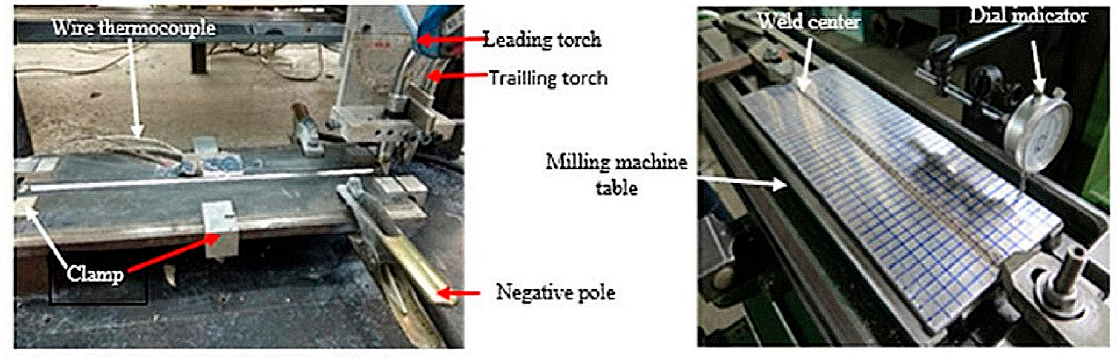
Figure 3. Setup for tandem MIG welding AA5052.